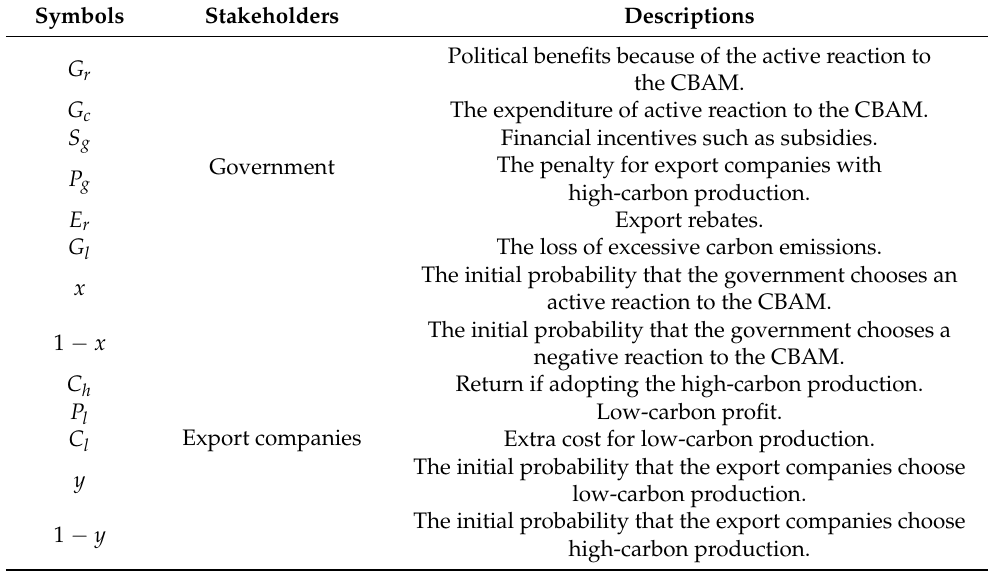
Table 1. Parameter definitions of the evolutionary game model.